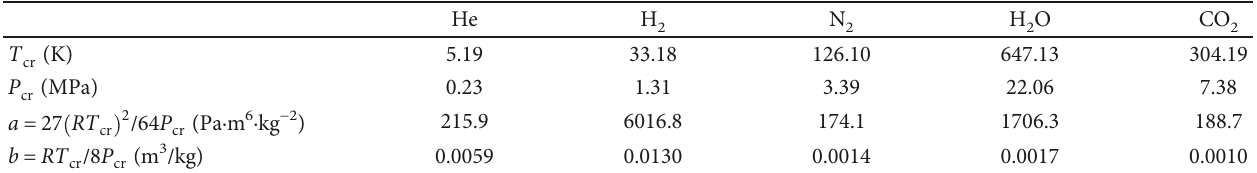
Table 1: van der Waals